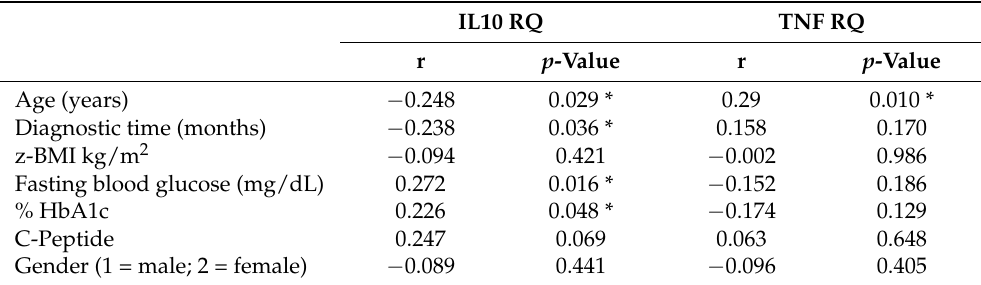
Table 3. Gene expression of IL-10 and TNF- α according to some parameters of the patients included in the study.